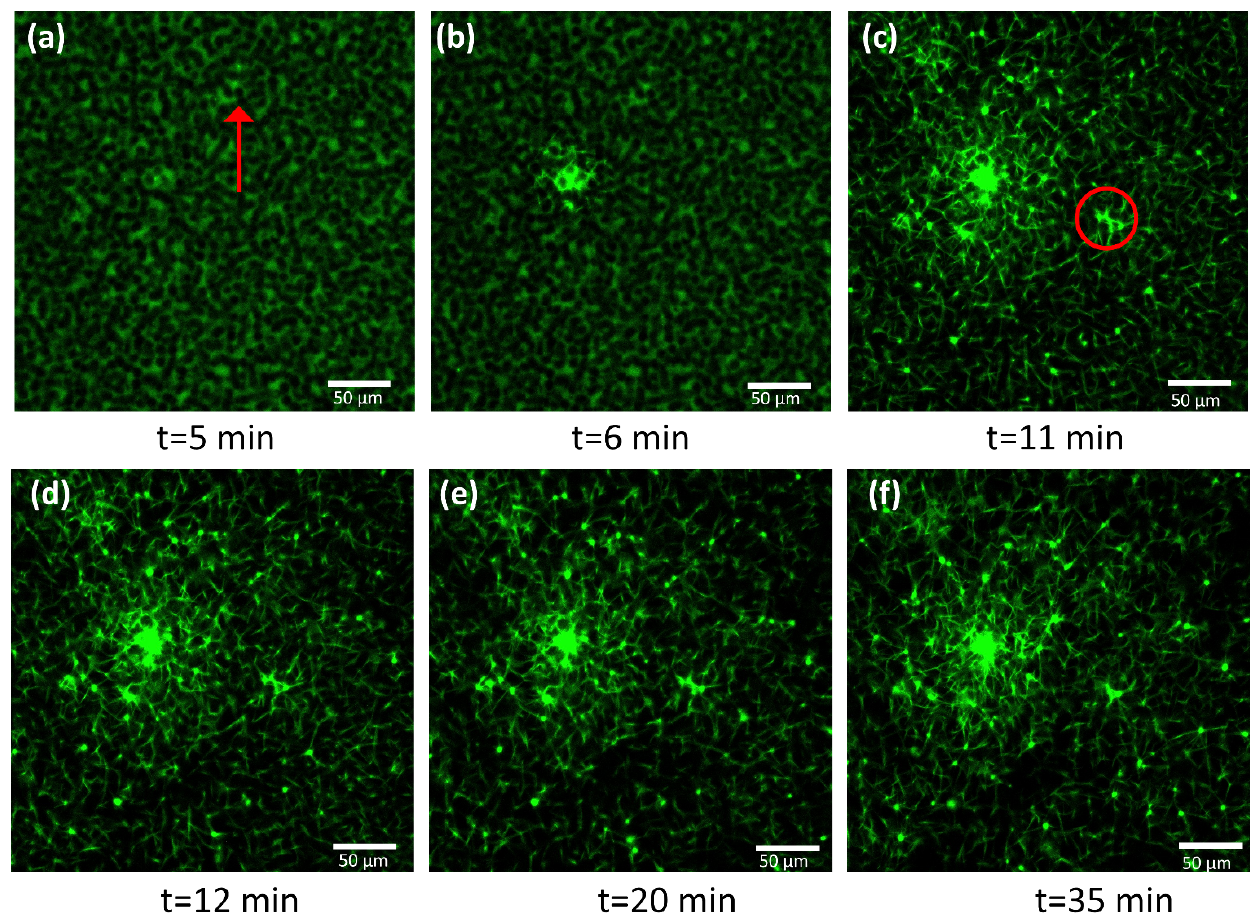
Figure 5. ( a – f ) Confocal-microscopy frames at different times since the addition of calcium solution. The red arrow in figure ( a ) indicates the dark shadow of a red cell. The green fibers correspond to the fibrin network labeled using fibrinogen from human plasma Alexa Fluor™ 488 conjugate.